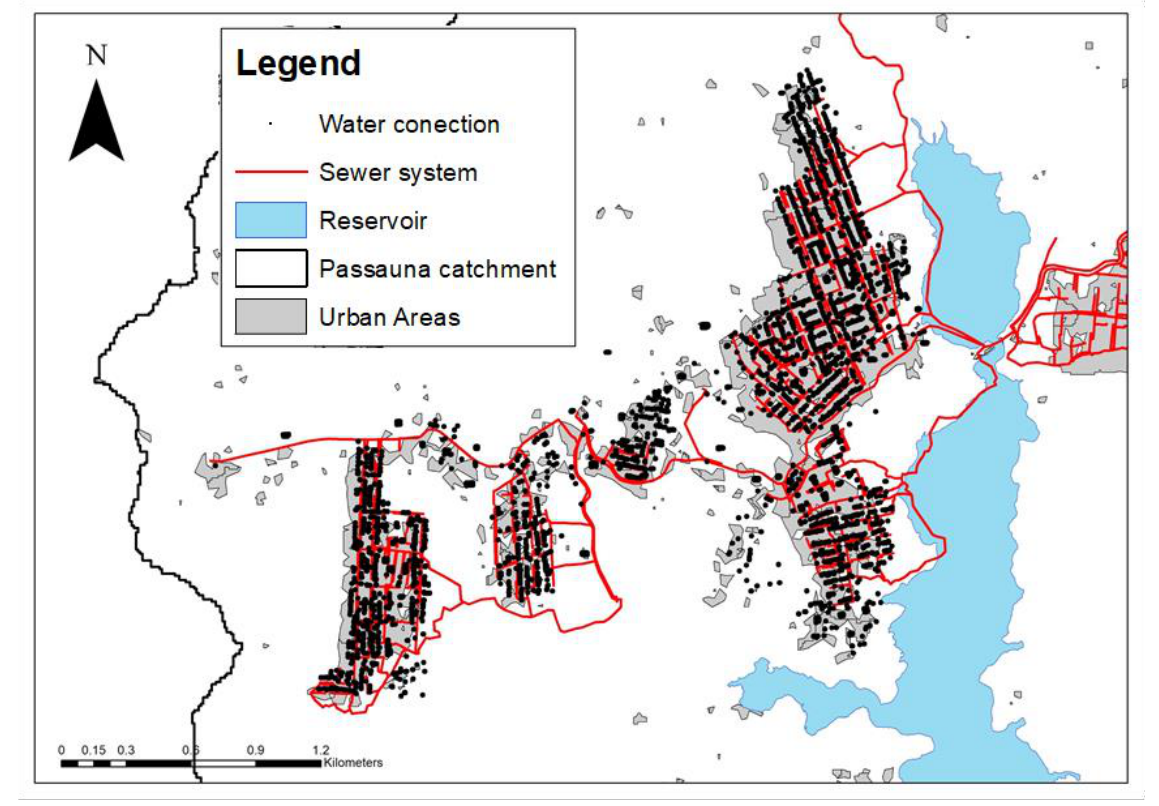
Figure 8. Sewage system and drinking water connections in the region of Ferraria.